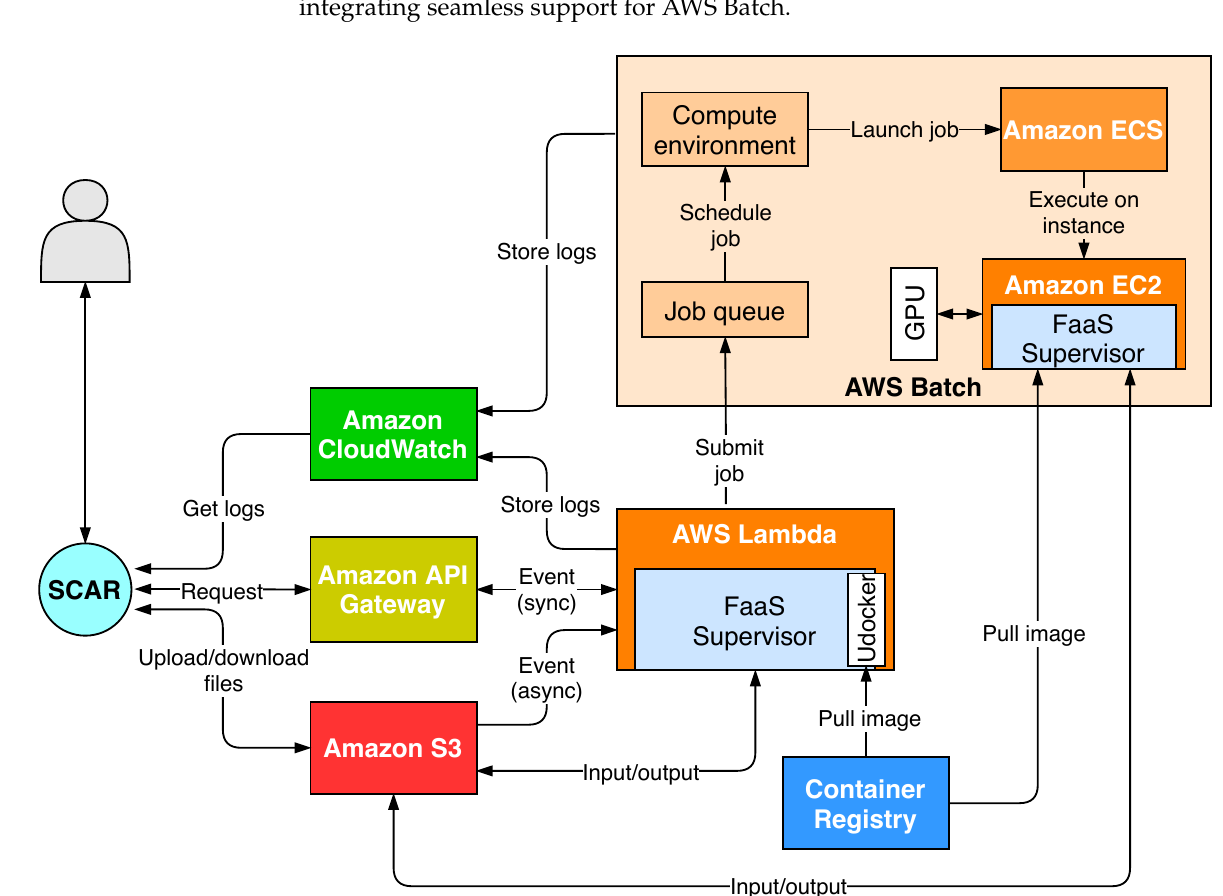
Figure 1. Architecture of the SCAR platform integrated with AWS Batch in order to support long-running and GPU- accelerated